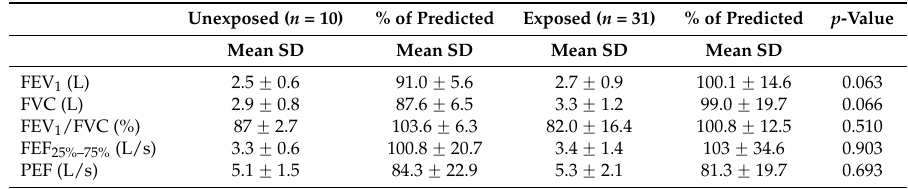
Table 2. Lung function data in self-reported unexposed versus exposed adults. Unexposed ( n = 10) % of Predicted Exposed ( n = 31) % of Predicted p -Value